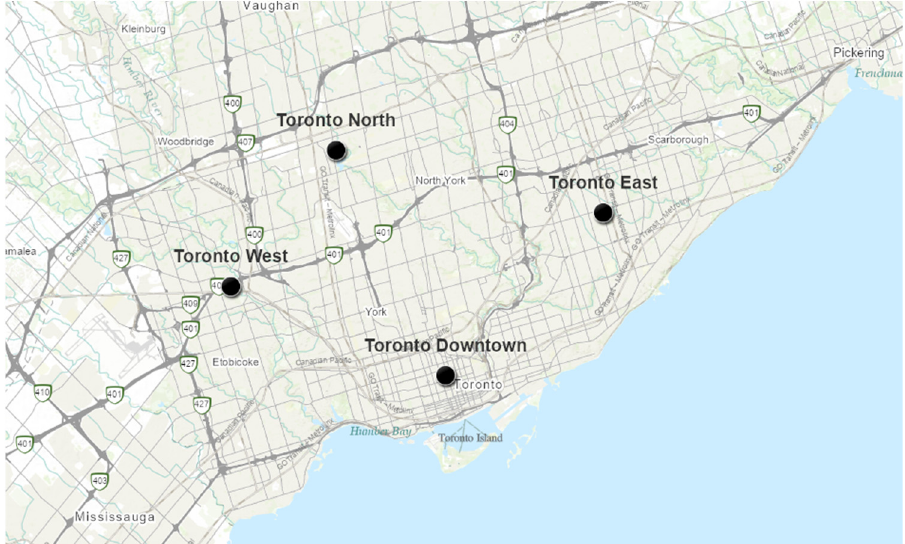
Figure 1. Map of air quality measuring station locations within Toronto, Ontario, Canada. Toronto East (43.75° N, 79.27° W) and Toronto West (43.71° N, 79.54° W) were used in this study. Due to data issues, Toronto North and Toronto Downtown were not used in this analysis. The scale is 1:220,000.